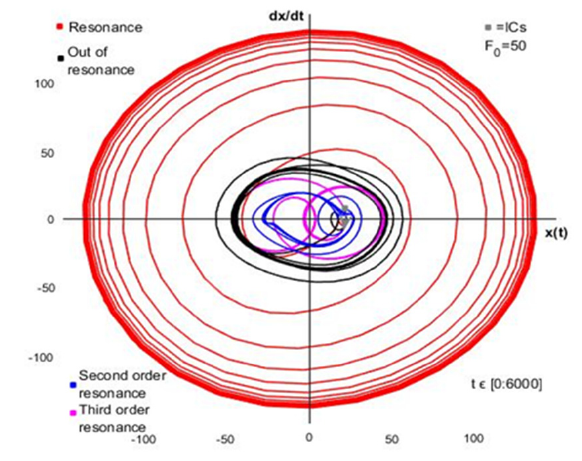
Figure 3. Systems with different degrees of resonance subjected to loading expressed by Equation (6) in the phase plane . Reproduced from [13], Published by IOP Publishing 2017.